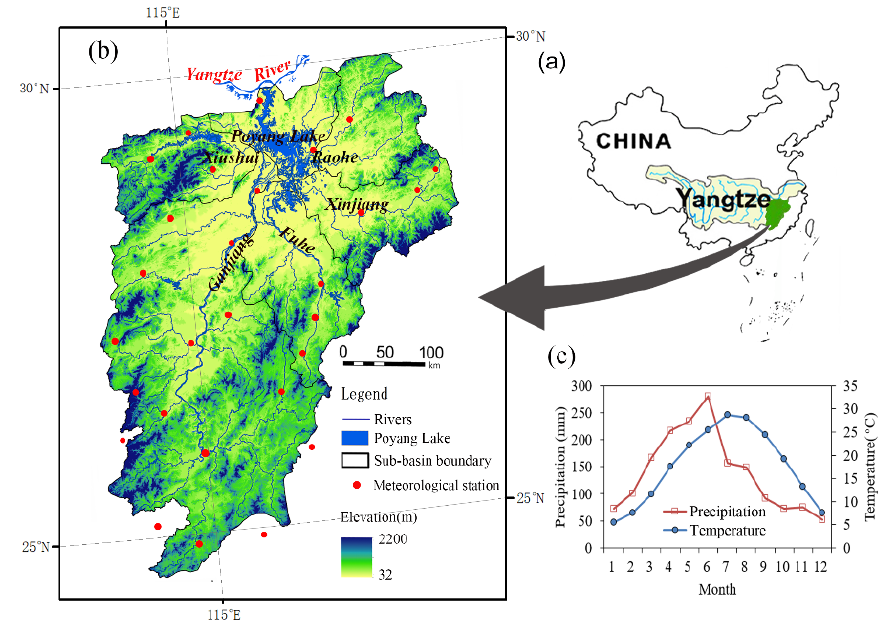
Figure 1. Geographical environment of the Poyang Lake basin: ( a ) location of the basin in China; ( b ) monthly precipitation and temperature of the basin; ( c ) topography and water system of the basin with meteorological stations marked.